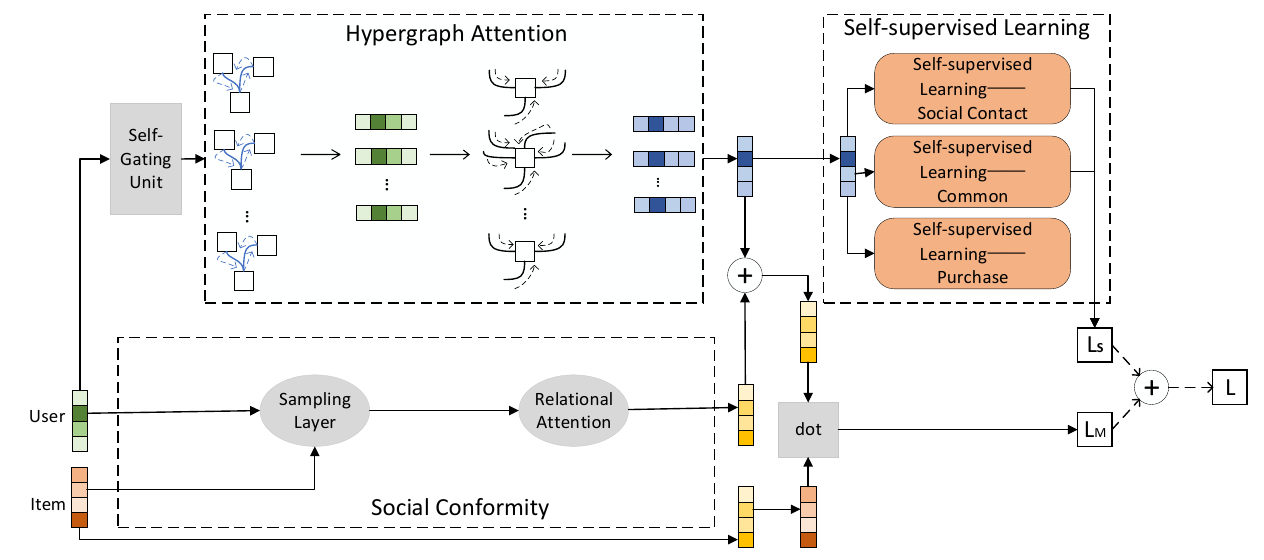
Figure 2. The framework of HGATH. To facilitate the understanding of the forthcoming text and formulae we introduce the nomenclature of symbols used in this paper in Table 2. Table 2. The nomenclature of mathematical symbols used in this